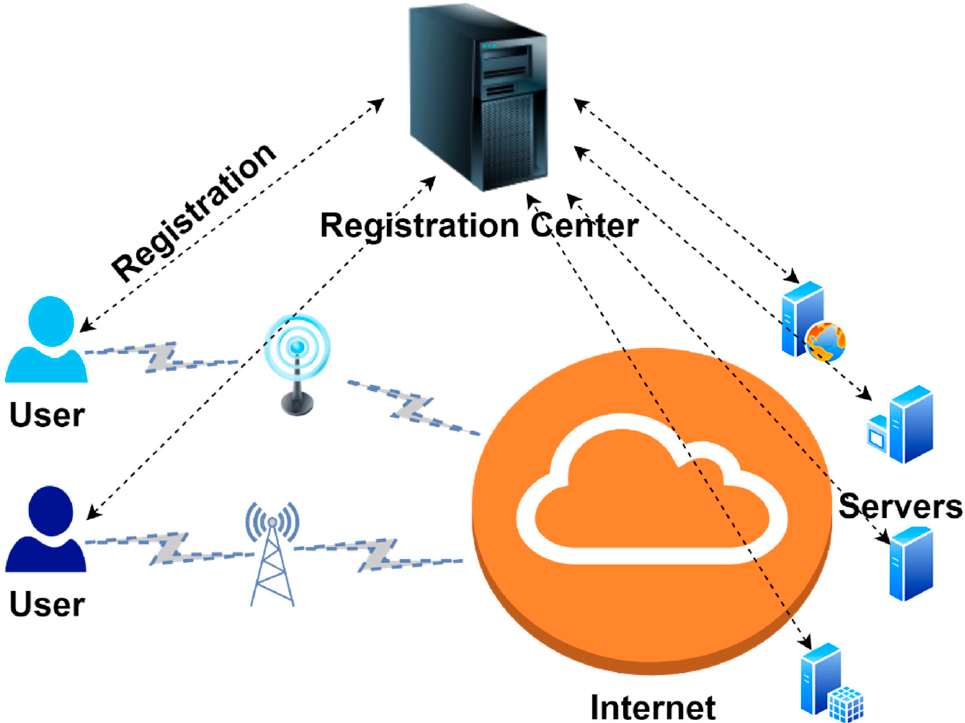
Figure 1. Network model of multi-server environment.